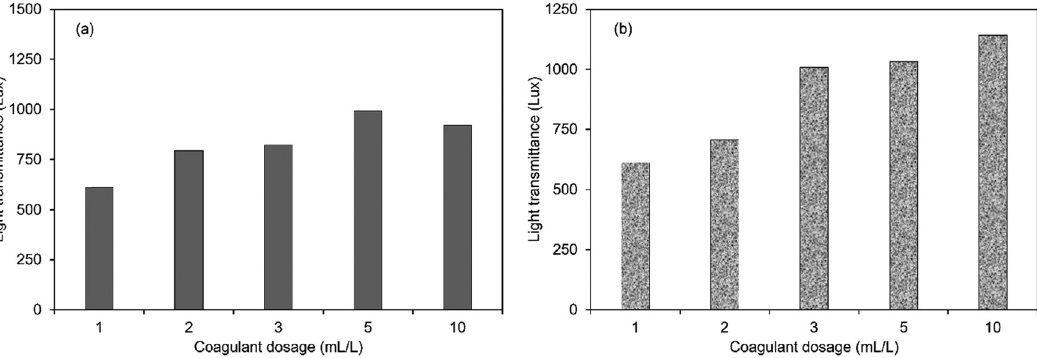
Figure 5: E ff ect of natural coagulant dosage on the transmittance of light. Natural coagulants were L. leucocephala ( a ) and S. grandi fl ora ( b ) .